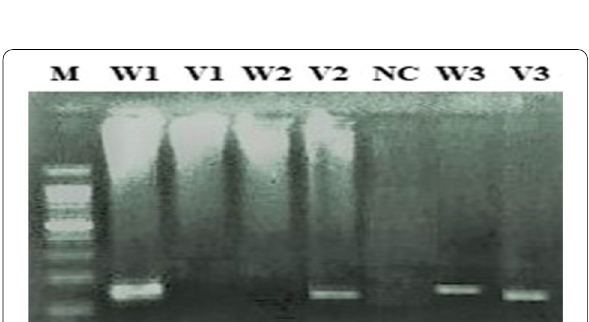
Fig. 4 Representative picture of AS-PCR products for detection of L858R mutation in exon 21 of EGFR gene. Two tube reaction in which lanes marked as “W” contain bands pertaining to wild allele and “V” contains bands pertaining to variant allele of same sample.